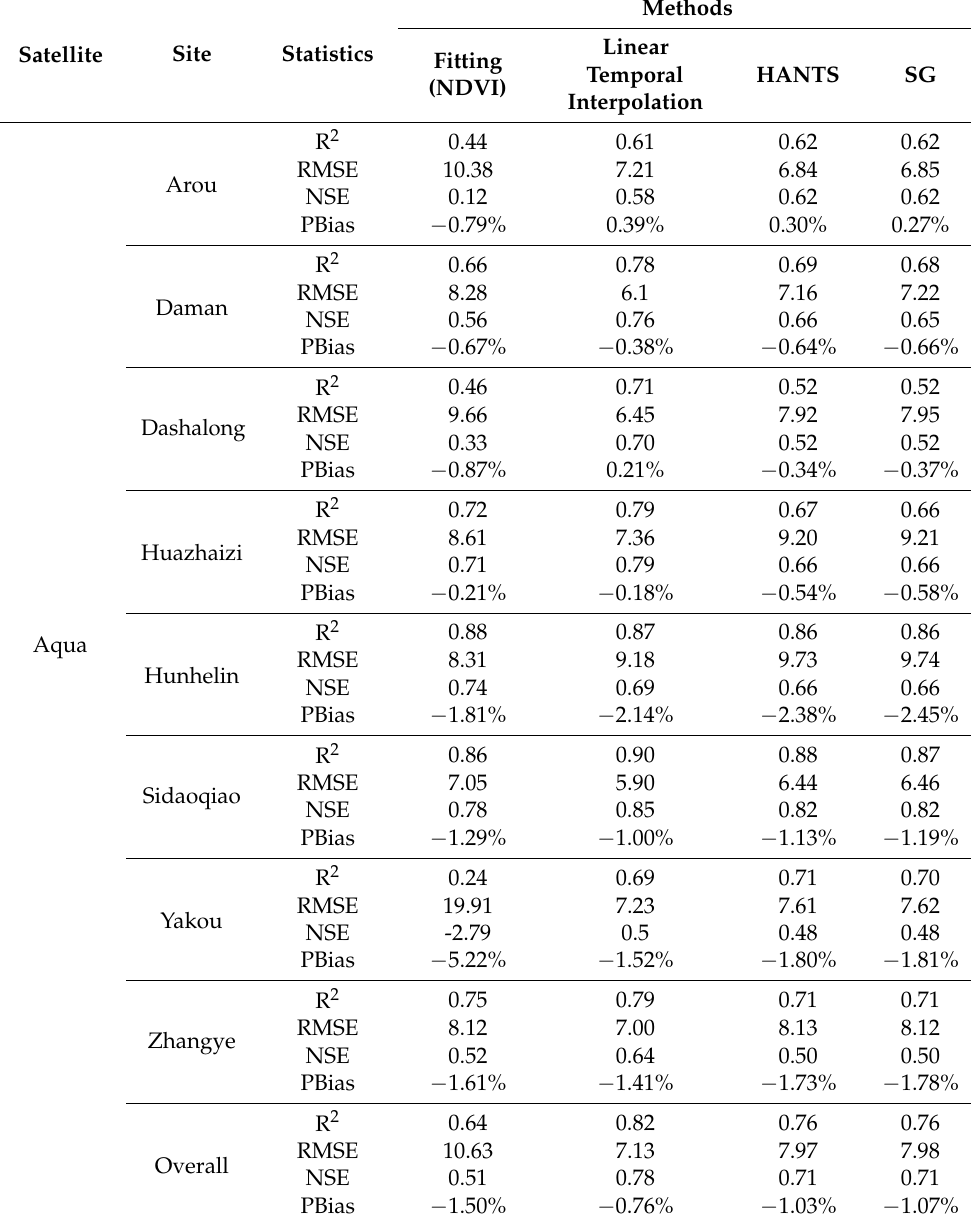
Table 3. The general performance results of reconstructed LST using temporal and spatial methods based on Aqua data from 2016 to